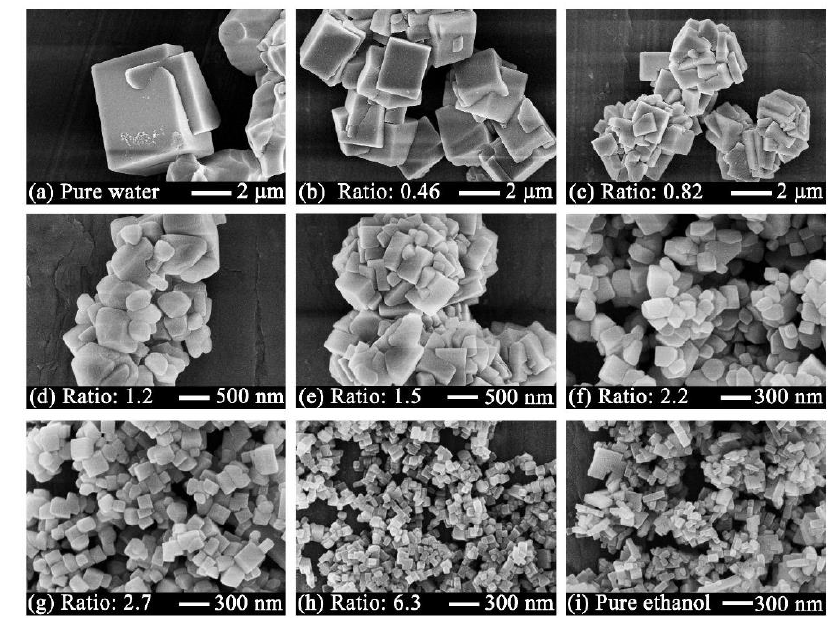
Figure 7. Fine-tuning crystal size of KAUST-7 by varying ethanol-water (solvent) ratios in synthesis solution: ( a ) pure water, ethanol/water ratio of ( b ) 0.46, ( c ) 0.82, ( d ) 1.2, ( e ) 1.5, ( f ) 2.2, ( g ) 2.7, ( h ) 6.3, and ( i ) pure ethanol [125], with copyright permission from © 2018 Elsevier.